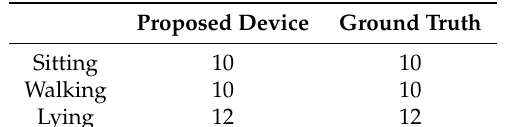
Table 1. Respiration rates in one minute.